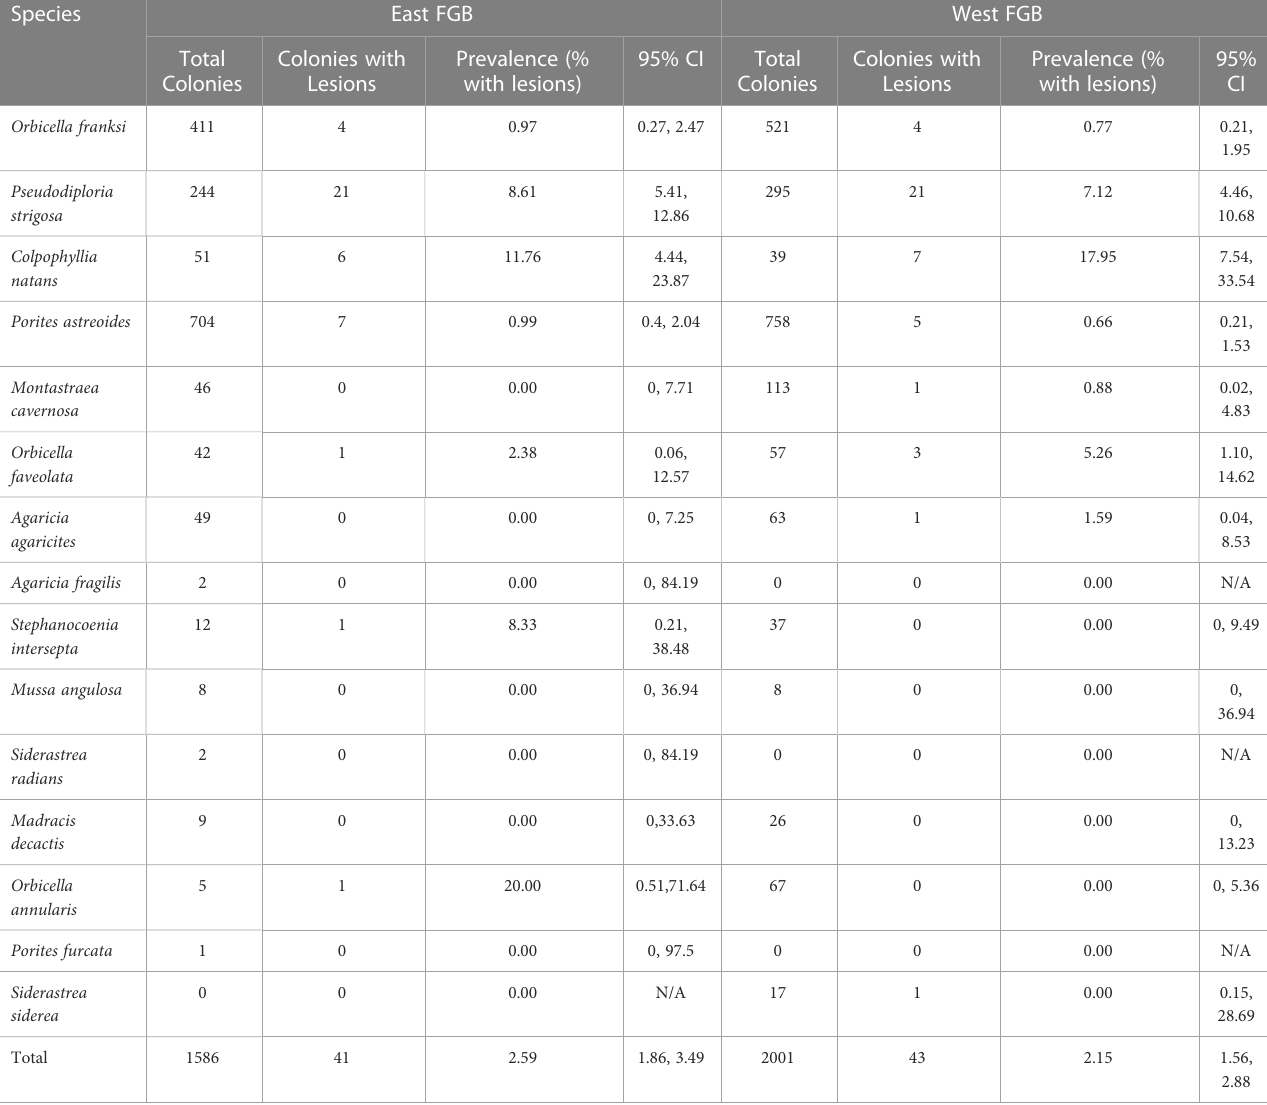
TABLE 1 Total number of coral colonies observed, number with disease lesions, and lesion prevalence by species with upper and lower 95% con fi dence intervals for East and West Flower Garden Bank (FGB, northwest Gulf of Mexico) repetitive monitoring